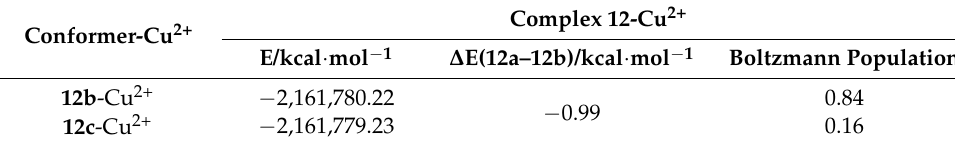
Figure 5. Electronic transitions evaluated for compound 12 in the absence and in the presence of Cu 2+ ; ( a ) being the conformer “b” and ( b ) being the conformer “c,” determined in Gaussian16 with CAM/B3LYP/def2TZVP and IEFPCM for water. Table 4. Energy difference between conformers “b” and “c” for complexes with Cu 2+ .